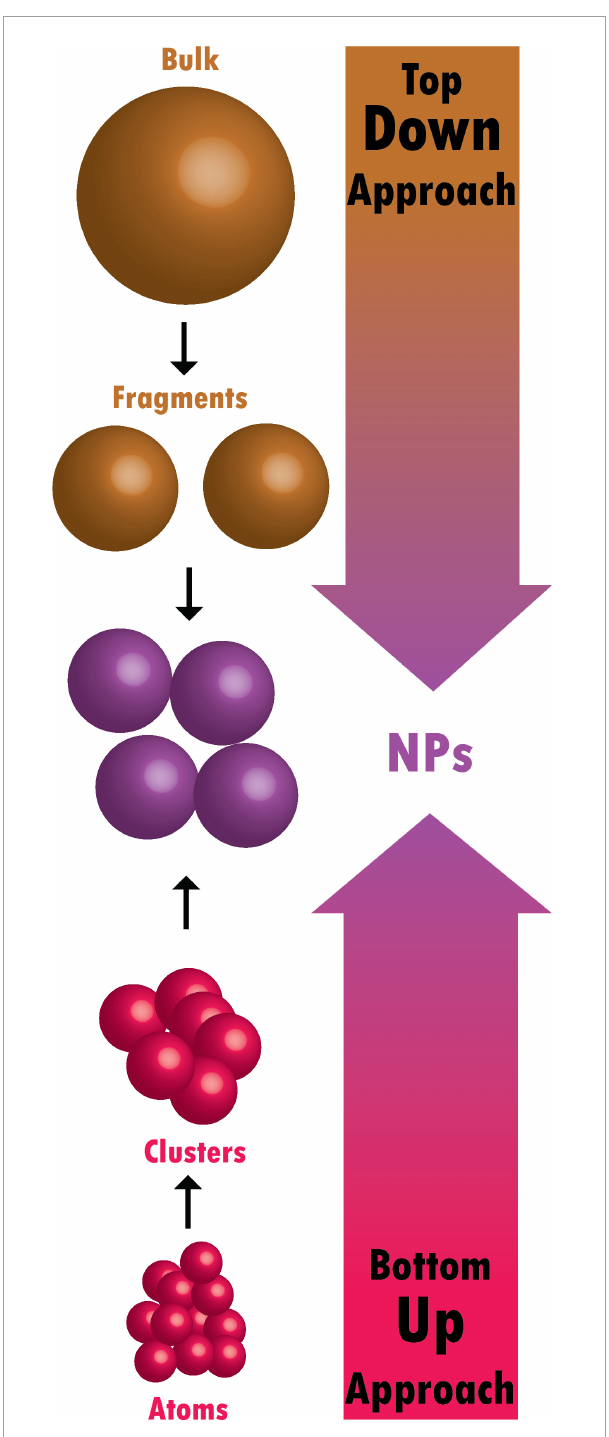
FIGURE2 Difference between top-down and bottom-up approaches.